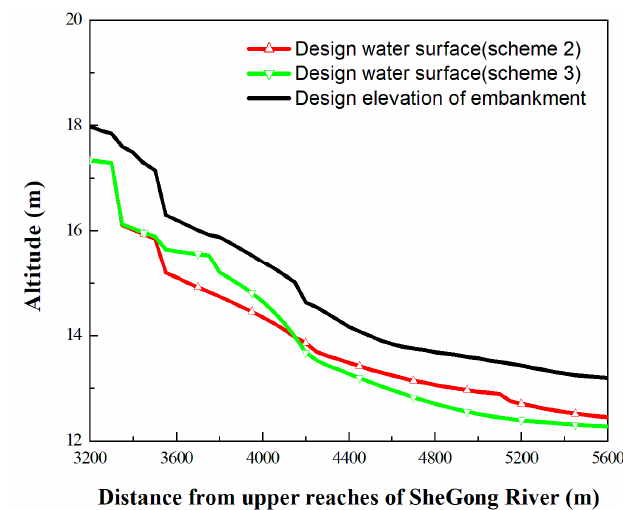
Figure 9. Simulation results of design water surface line.